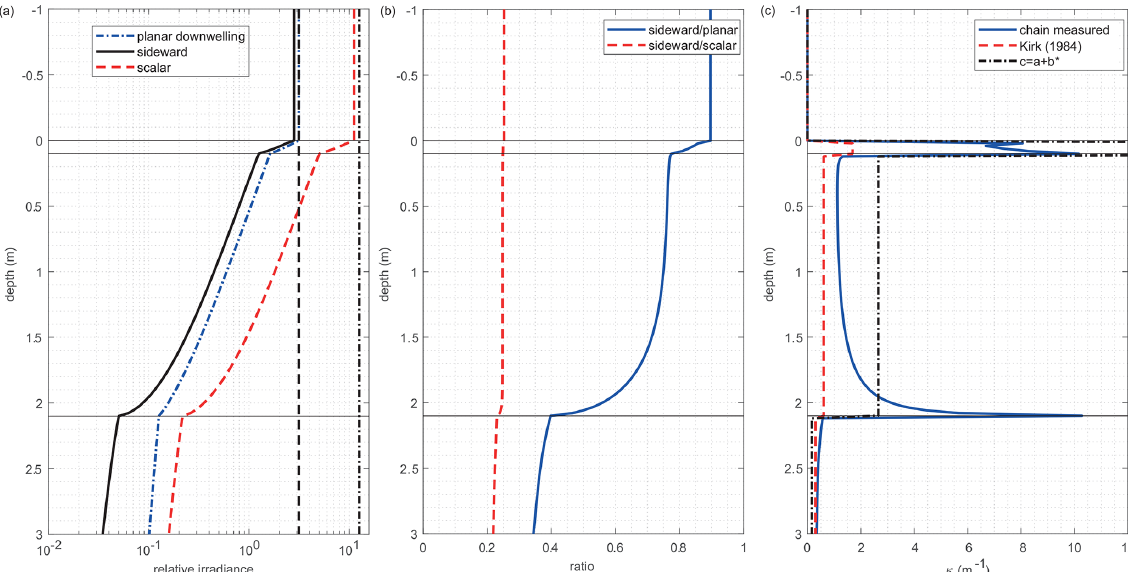
Figure 9. (a) Modeled irradiance curves for planar downwelling irradiance (blue dash dotted line), sideward irradiance (black solid line) and total scalar irradiance (red dashed line). Vertical black lines depict the values of π (dashed line) and 4 π (dash dotted line), representing the values of planar downwelling and total scalar irradiance, respectively. Horizontal black lines indicate the interfaces between atmosphere, surface scattering layer, ice interior and water. (b) Modeled ratios between sideward and planar downwelling (blue solid line), as well as sideward and total scalar irradiance (red dashed line). (c) Modeled attenuation coefficients as measured by the chain (blue solid line), as well as pseudo-IOP (inherent optical properties) attenuation coefficients derived from model IOP: diffuse attenuation coefficient parameterized according to Kirk (1984) (dashed red line) and the beam attenuation coefficient (dash dotted black line).